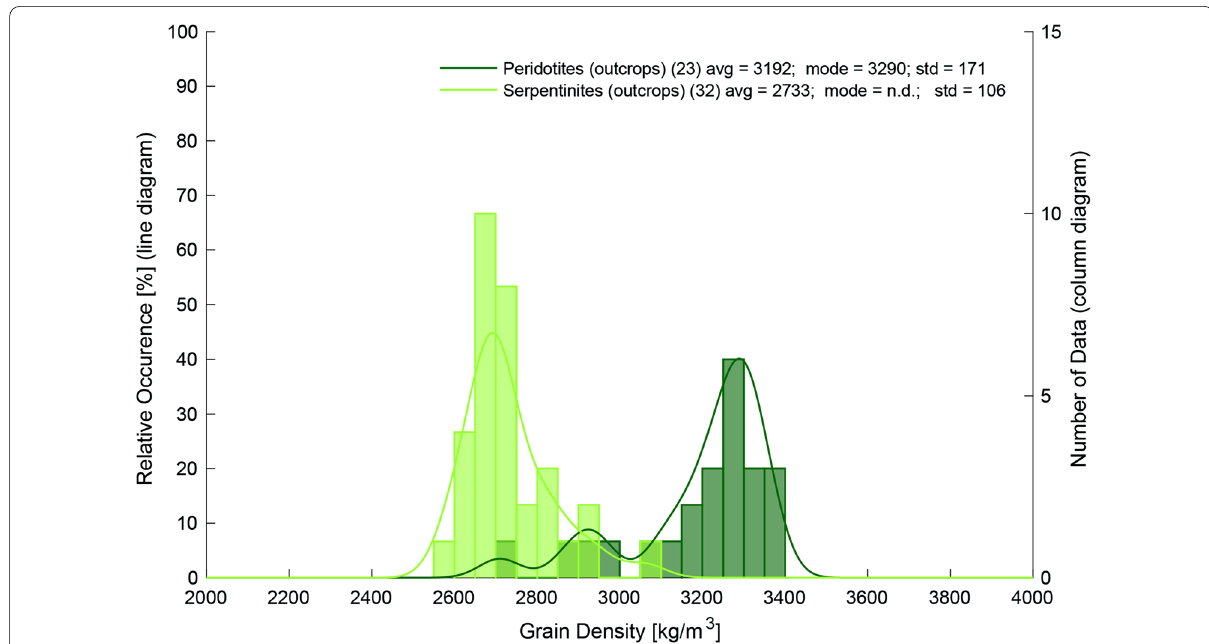
Fig. 9 Density values distributions for peridotites and serpentinites (see Fig. 7 caption for explanations). For these rock types only outcrop data were available and only in limited numbers. Both peridotites and serpentinites show distinct peaks in their distributions. The large standard deviation corresponds with the nature of the two rock types, serpentinites being the product of alteration of peridotites rather than to data variations due to measurement differences or uncertainties (see